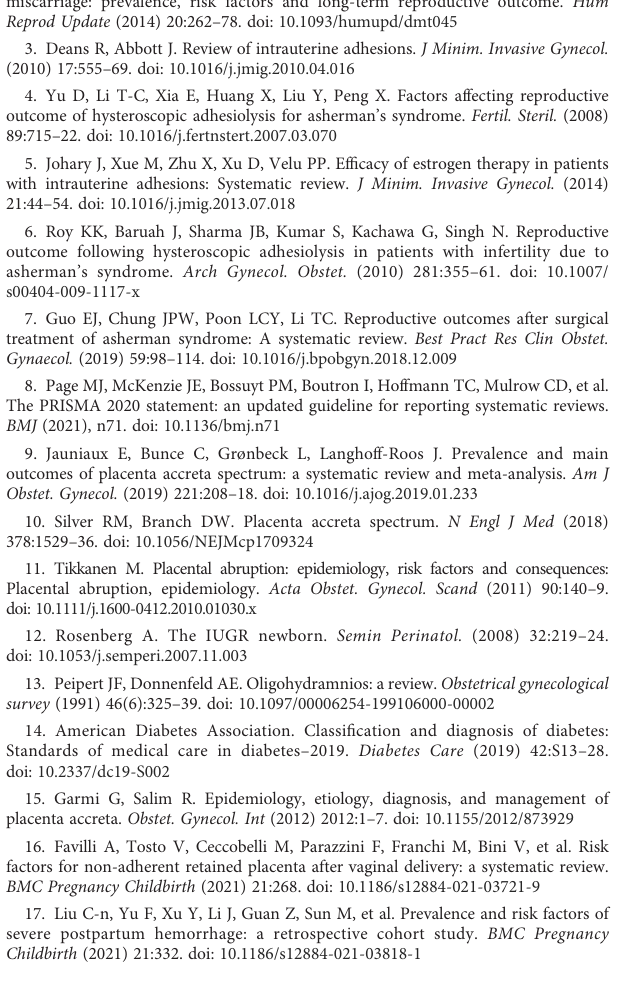
SUPPLEMENTARY FIGURE 1 Forest plot diagrams of ectopic pregnancy (A) , oligohydramnios (B) , intrauterine growth restriction (C) , gestational hypertension (D) , and gestational diabetes mellitus (E) .